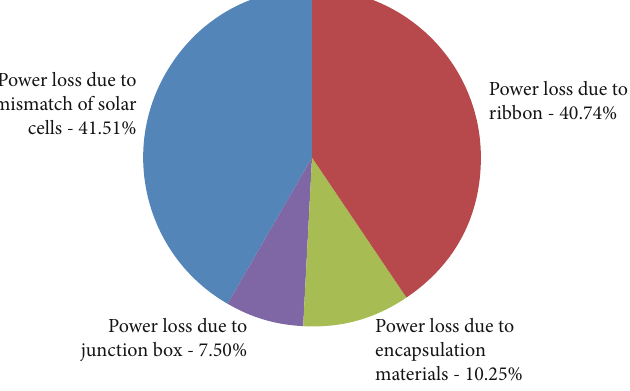
Figure 8: Distribution of power loss in a solar module